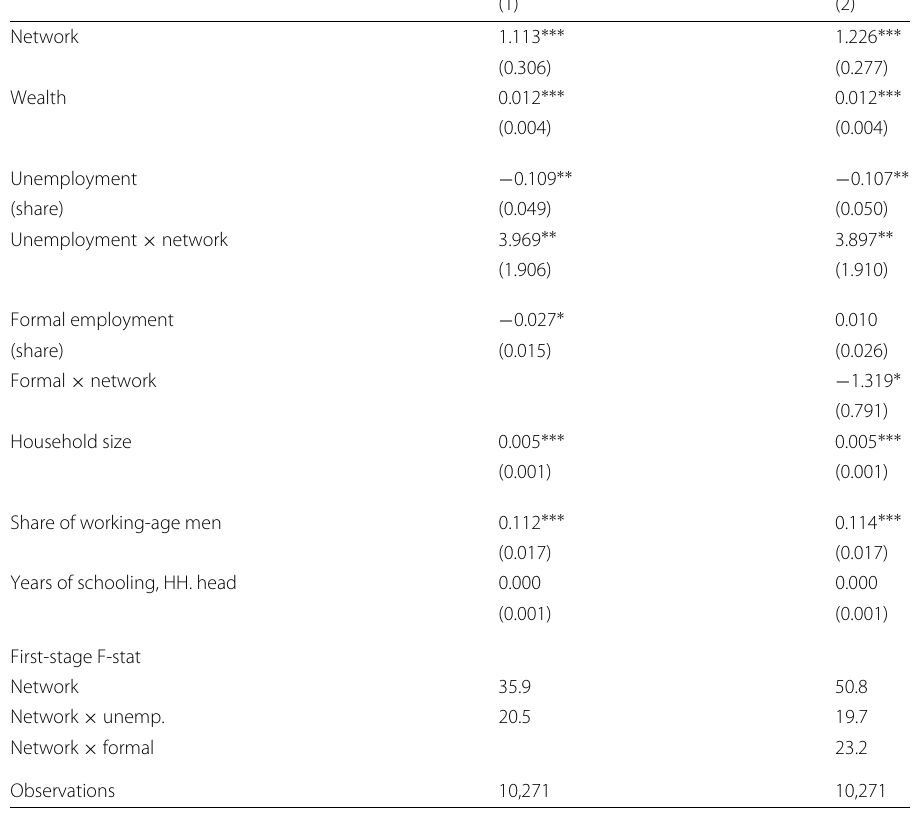
Table 4 Determinants of migration: unemployment and formality (IV estimates) (1)